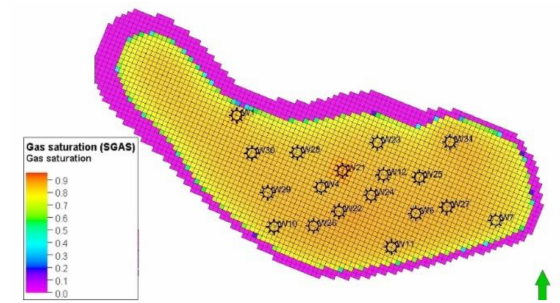
Figure 7. Initial gas saturation along vertical cross section (A–A’).